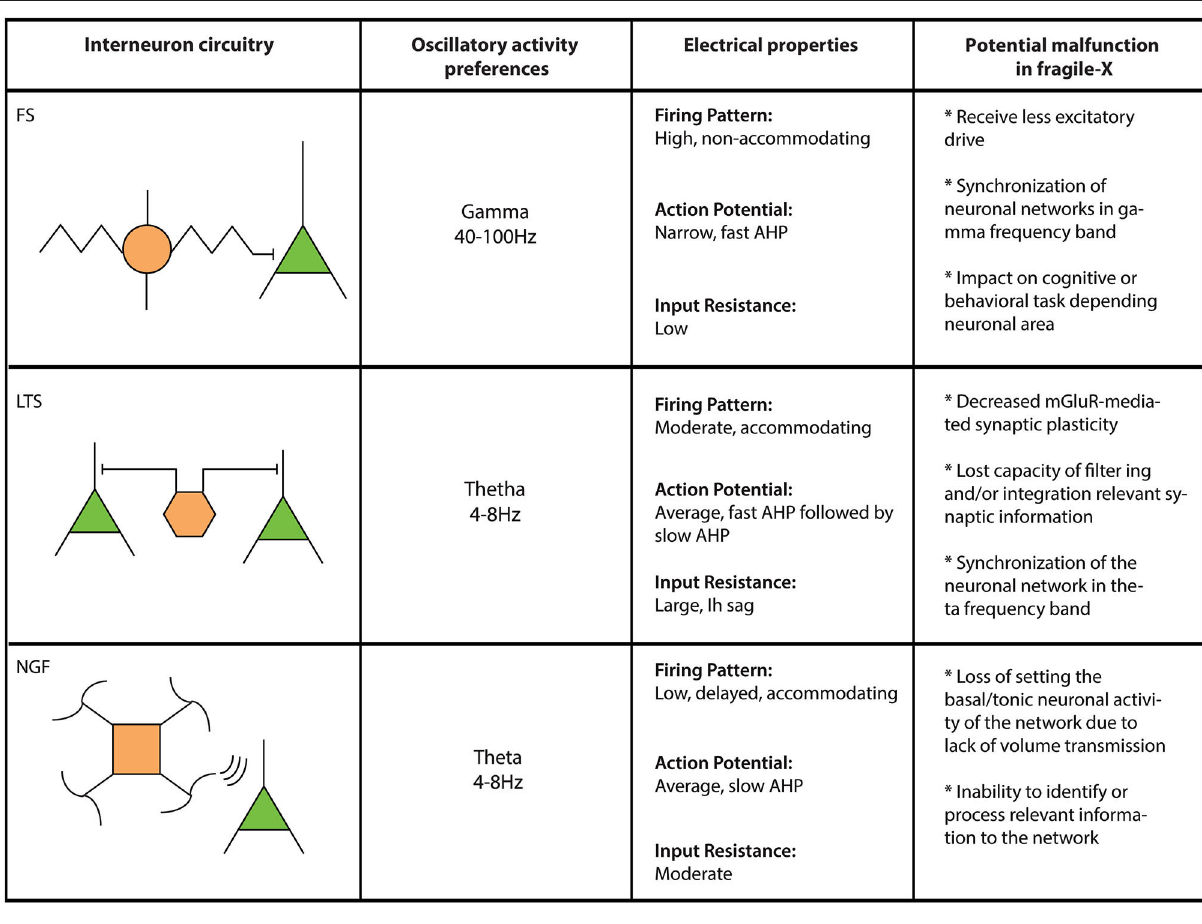
FIGURE 1 | Comparative table for interneuron populations in FXS . Three different interneuron types (FS: Fast spiking; LTS: Low threshold spiking and NGF: Neurogliaform cells) are compared here regarding their